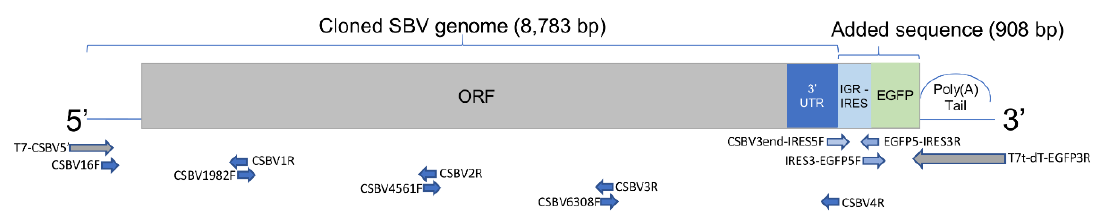
Figure 1. Diagram of the bicistronic SBV clone cDNA template. The bicistronic design was comprised of two ORFs, the ORF of SBV and IRES-EGFP as the second ORF. Black queen cell virus intergenic IRES (IGR-IRES) was used to induce the expression of EGFP. The cDNA template included a full SBV genome, and the untranslated regions (UTRs) of both ends were unmodified. Arrows beneath the diagram indicate the primers used to produce the fragments before assembling (dark blue indicated primers for SBV genome; light blue indicated added sequence; grey indicated terminals with modifications). The primers are listed in Table S1. The full sequence, including partial vector sequences, has been submitted to GenBank